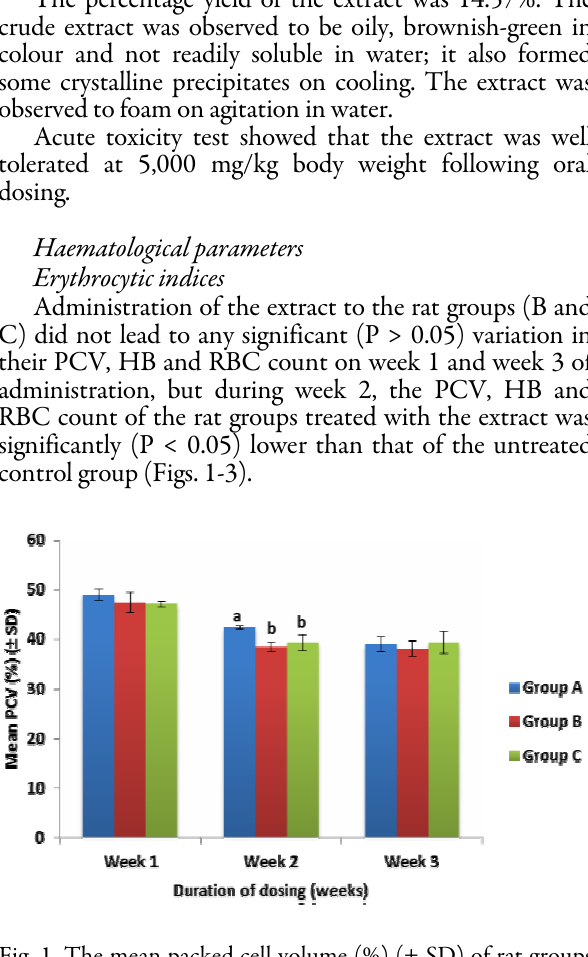
Fig. 1. The mean packed cell volume (%) (± SD) of rat groups given varied doses of methanolic leaf extract of T. occidentalis . Group A (untreated control), group B (200 mg/kg body weight daily) and group C (800 mg/kg body weight daily)